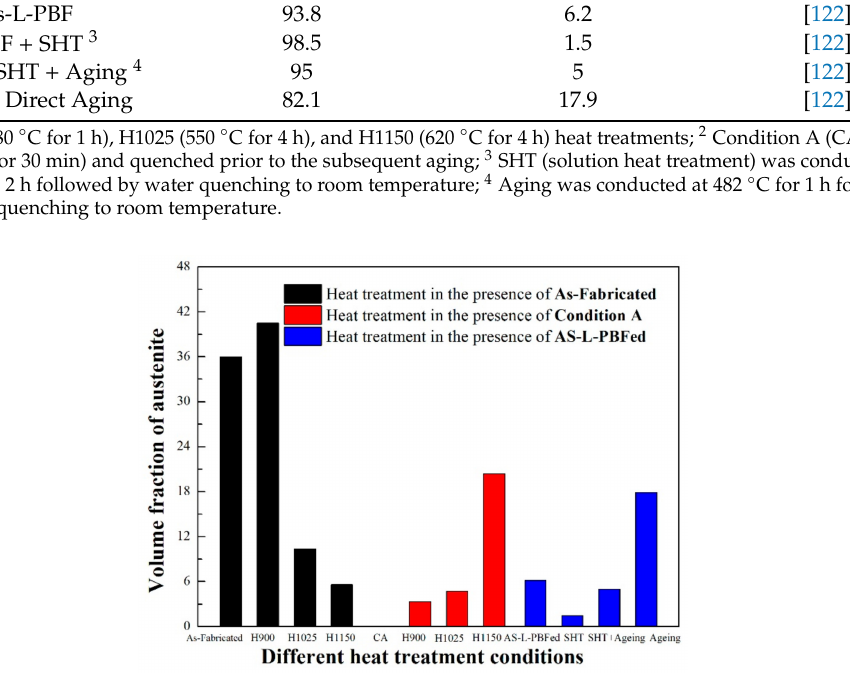
Figure 9. Volume fraction of austenite under different heat treatment conditions, material: 17–4 steel